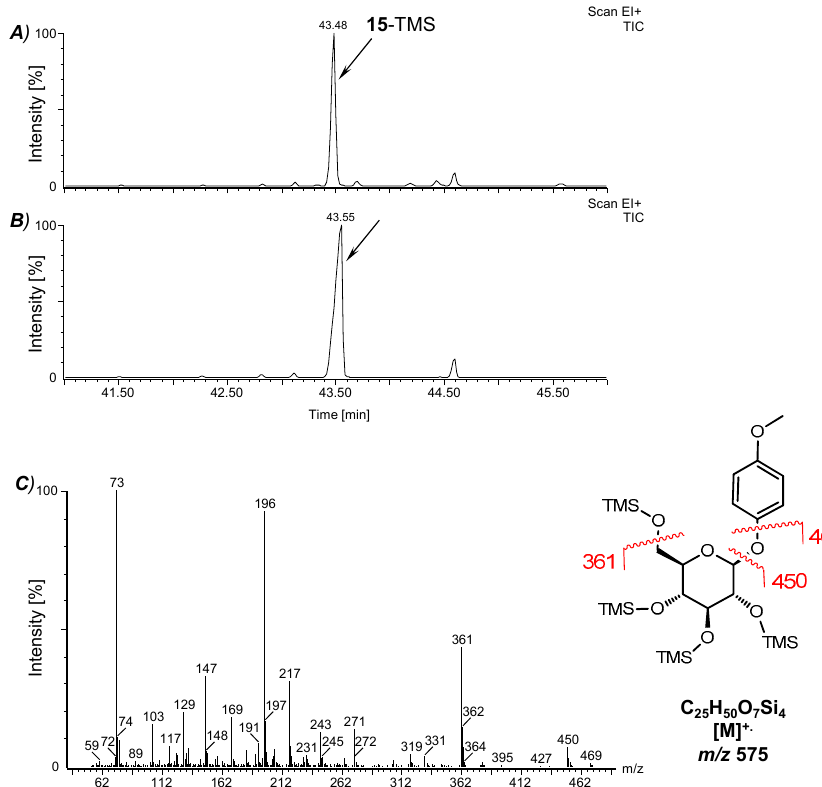
analysis of AcOEt extracts and calculated based on the internal standard eicosane ( n -C 20 ); STD ( n = 3).